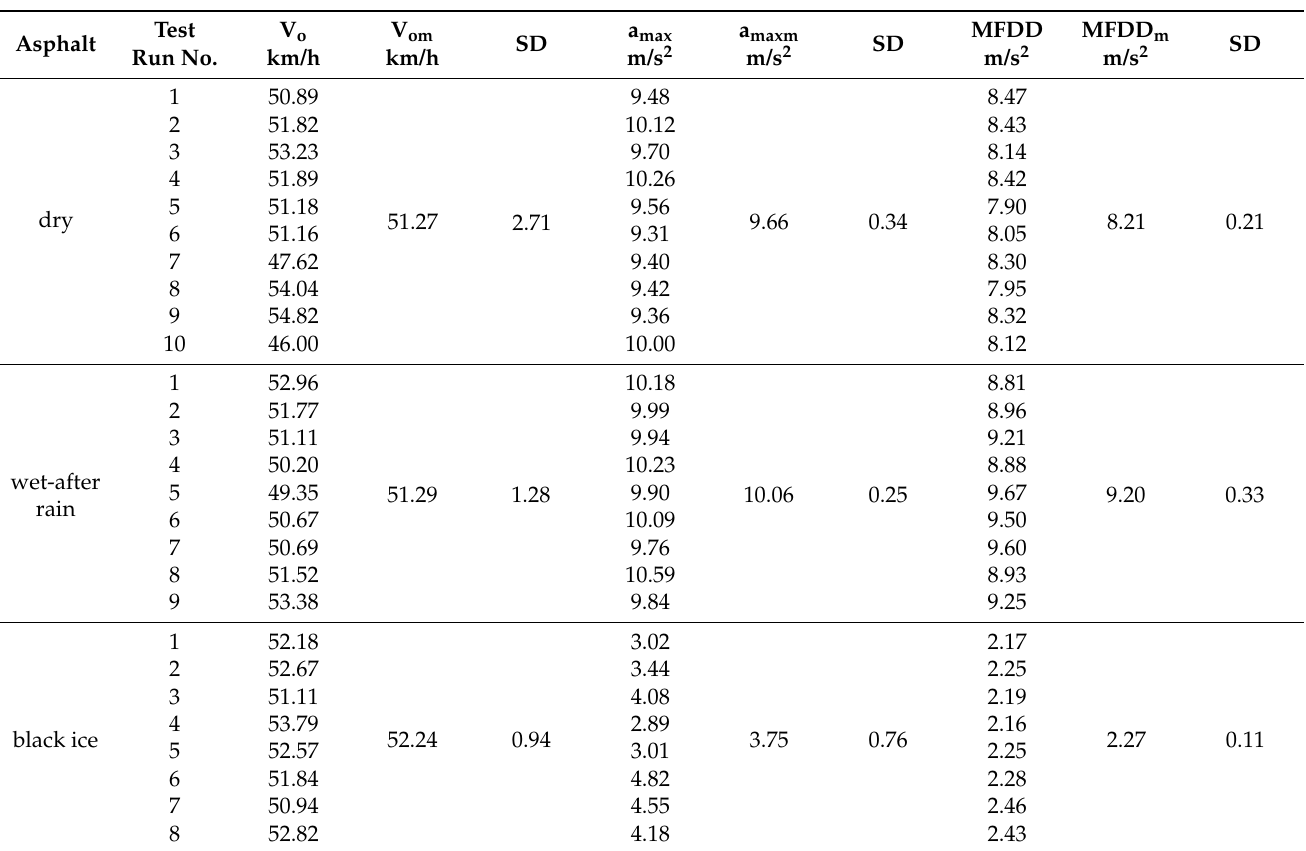
Table 5. The Ford Transit’s deceleration during rapid braking on a dry surface, a wet (after rain) asphalt surface, and a surface covered with a thin ice layer with the initial speed of approximately 50